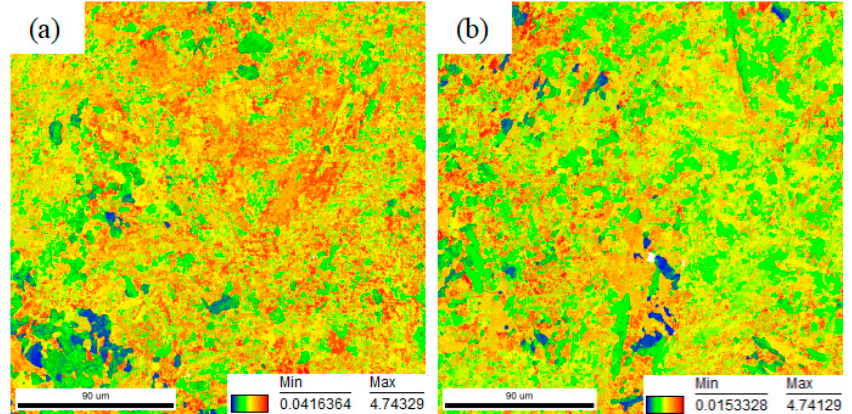
Figure 17. Comparison between the inter-layer area and deposited area on the Taylor factor: ( a ) Inter-layer area; ( b ) deposited area.